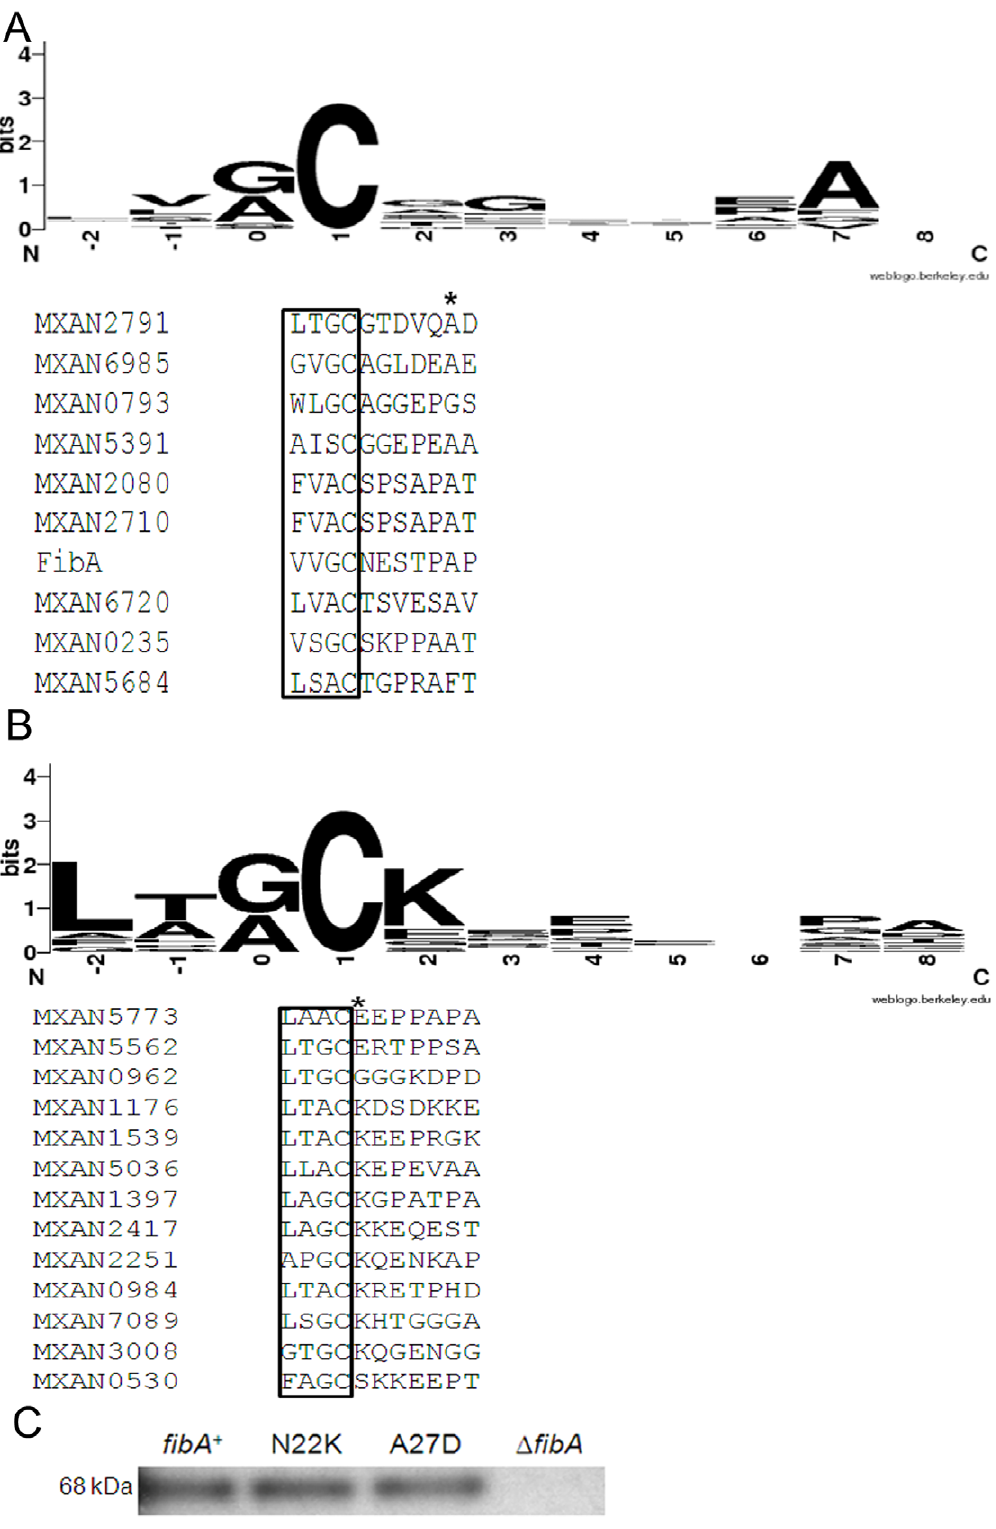
Figure 3. Bioinformatic analysis of first eight amino acids of N-terminus of M.xanthus lipoproteins. (A) Multiple sequence alignment of ECM proteins using WebLogo. The lipobox (highlighted by a box made of dashed lines) and the following seven amino acids of the N-terminal region of mature lipoproteins were aligned using WebLogo. Seven ECM lipoproteins have alanine at the 7 th position (highlighted by a solid box). (B) 8/12 predicted IM lipoproteins have lysine at the 2 nd position (highlighted by a solid box). (C) Western blot analysis of 18 h developing cells using Mab2105 primary antibody. Strains used include LS2760 (WT FibA), LS2208 ( D fibA ), LS2761 (N22K FibA), LS2764 (A27D FibA).